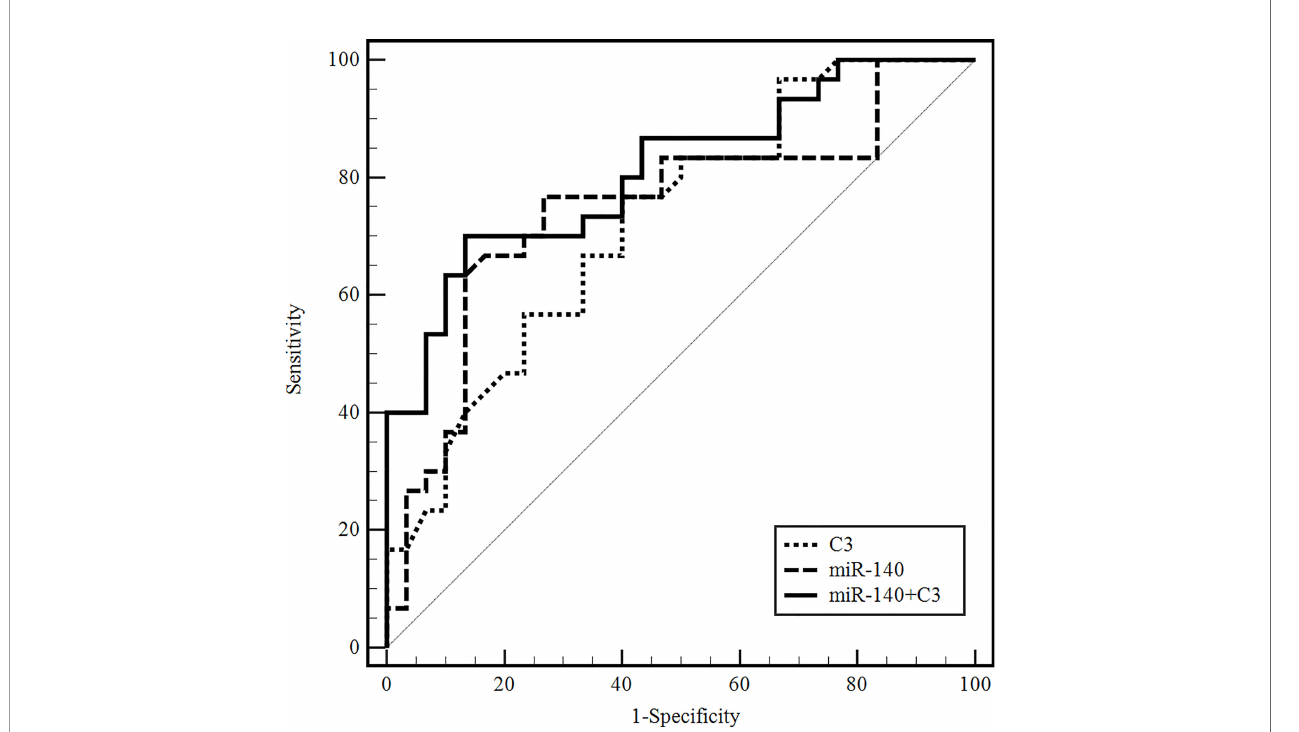
FIGURE 4 | ROC curves to validate the differential diagnostic value of exosomal miR-140-5p, serum C3, and their combinations for anti-NMDAR encephalitis. (C3, complement 3; C4, complement 4; miR-140, microRNA-140-5p).